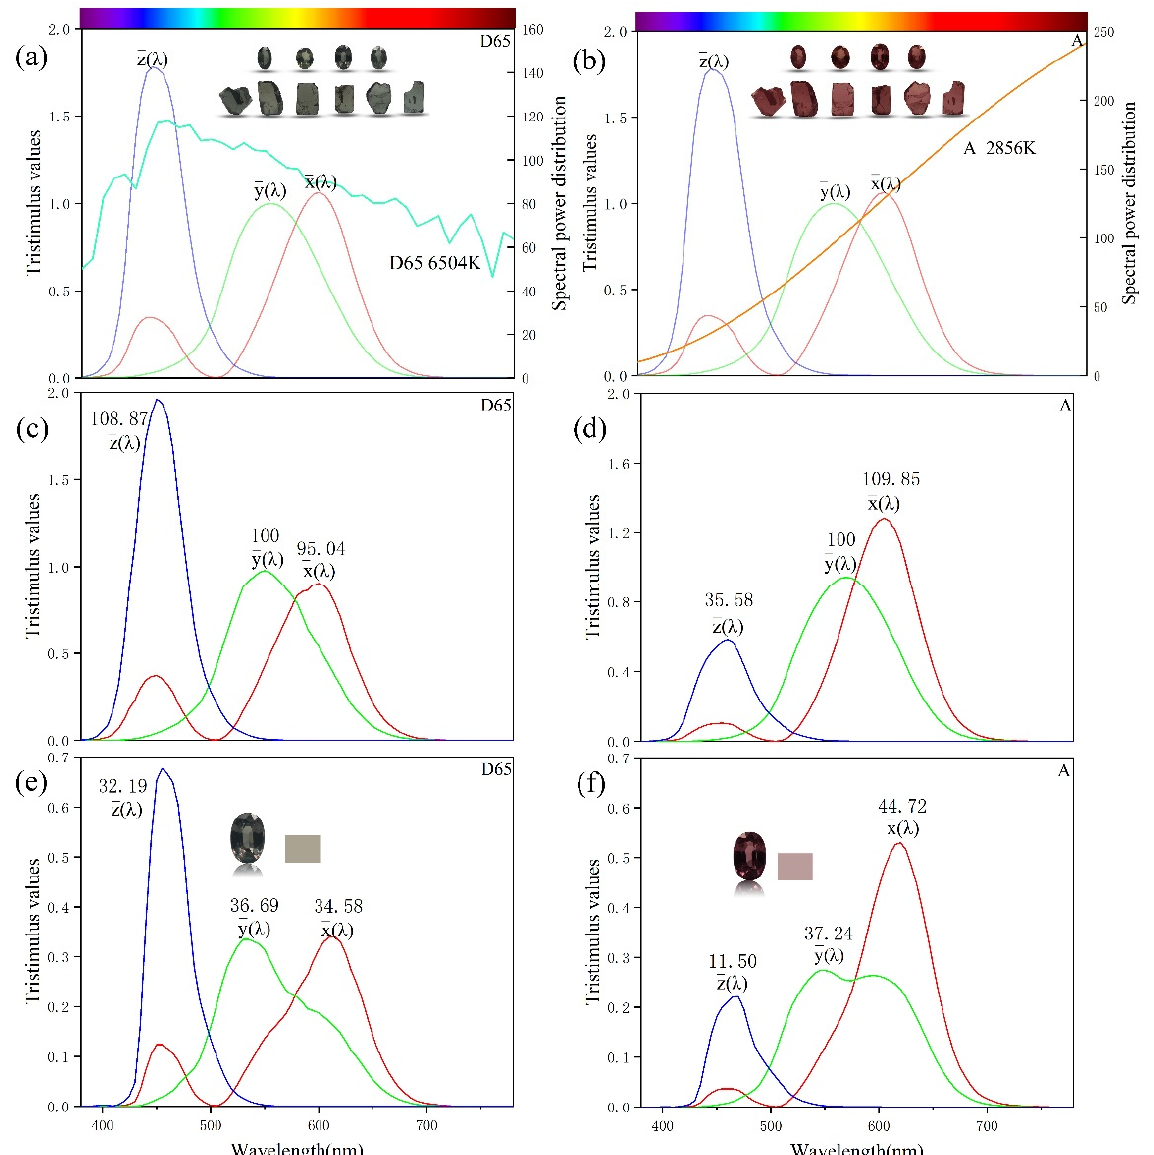
Figure 6. Analysis and explanation of the alexandrite effect (with sample B3 as an example). The spectral response curves of the CIE1931 XYZ colour matching functions are shown. ( a ) The spectral power distribution of the CIE D65 representing daylight (colour temperature, 6504 K). ( b ) The spectral power distribution of the incandescent light CIE A (colour temperature, 2856 K). ( c ) Response curves of spectra of D65 obtained from the colour-matching functions. ( d ) Response curves of spectra of A obtained from the colour-matching functions. ( e ) Response curves of the colour matching functions of the colour-changing garnet under D65. ( f ) Response curves of the colour matching functions of the colour-changing garnet under A. The tristimulus values and the simulated colour obtained by the integration of the curve are shown in the figure.